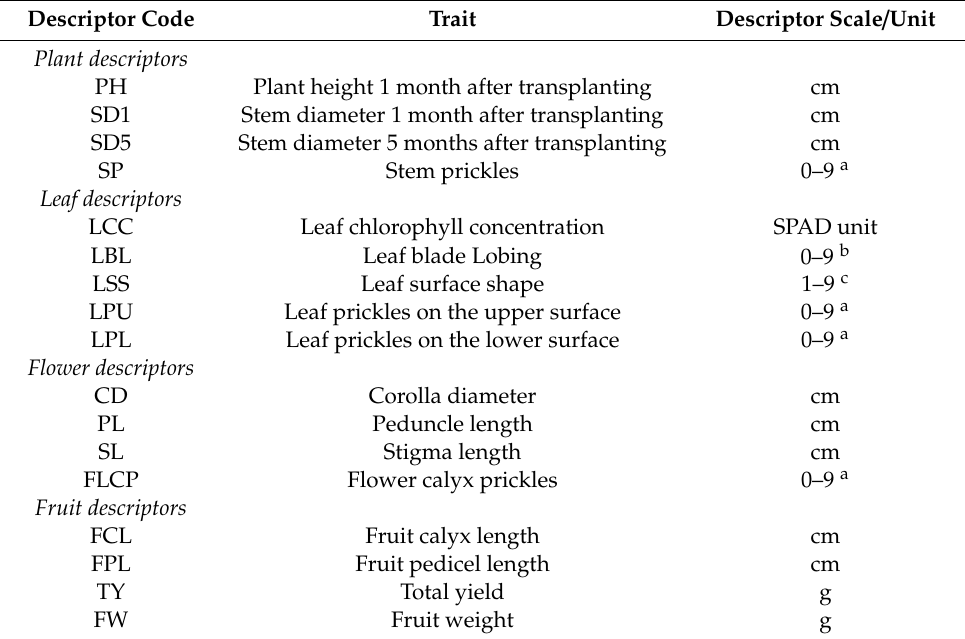
Table 2. List of traits used for ILs characterization with their abbreviations and